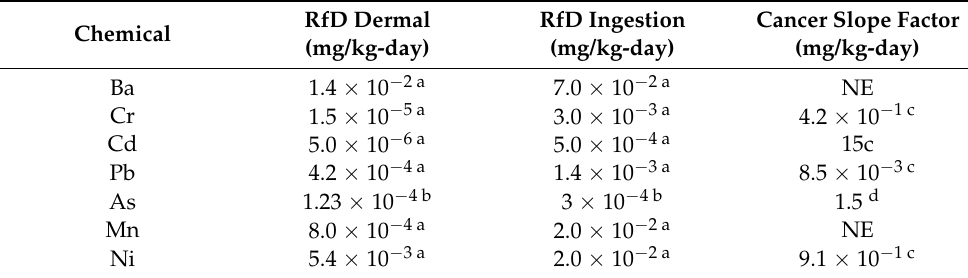
Table 2. Dermal and oral reference doses (RfD) and cancer slope factor (CSF). RfD Dermal RfD Chemical (mg/kg-day)